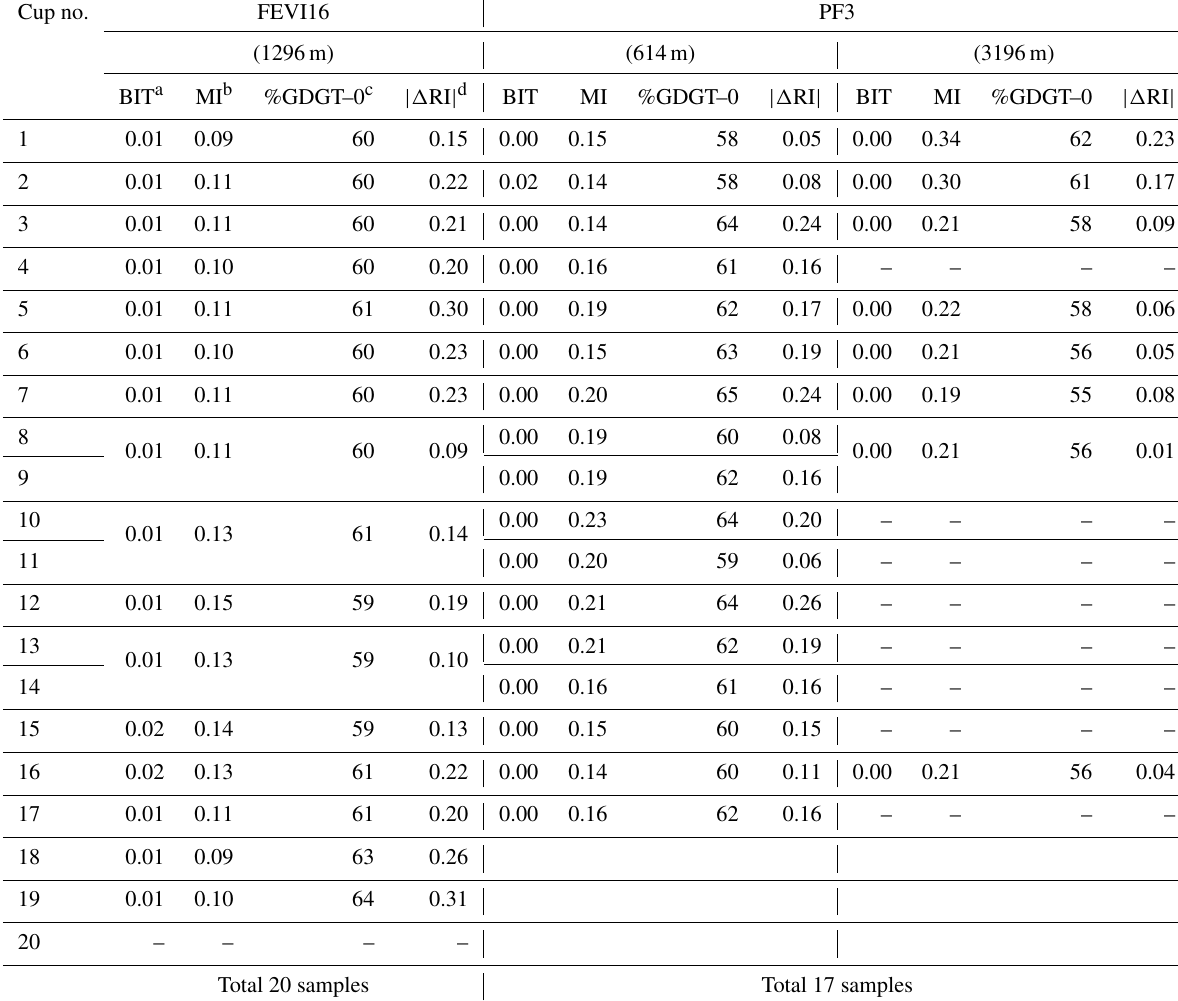
Table A1. Index values for assessing the terrestrial and/or methanogen GDGT inputs at FEVI16 and PF3 sediment traps. The exact sampling interval of each sample number at FEVI16 and PF3 can be found in PANGAEA (https://doi.pangaea.de/10.1594/PANGAEA.897268). Cup